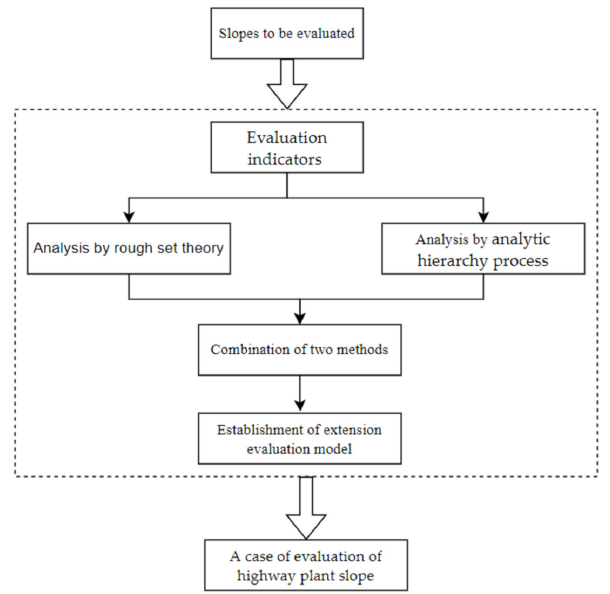
Figure 3. Flowchart describing the methodology applied for highway plant